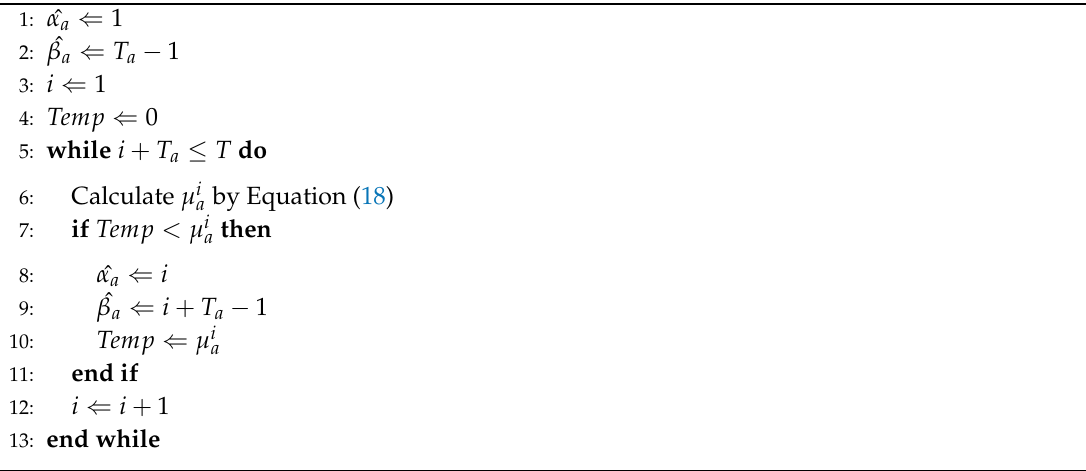
Figure 6. Example probability mass function (PMF) of an uncontrollable appliance. Algorithm 1: Preference Searching Algorithm for Uncontrollable